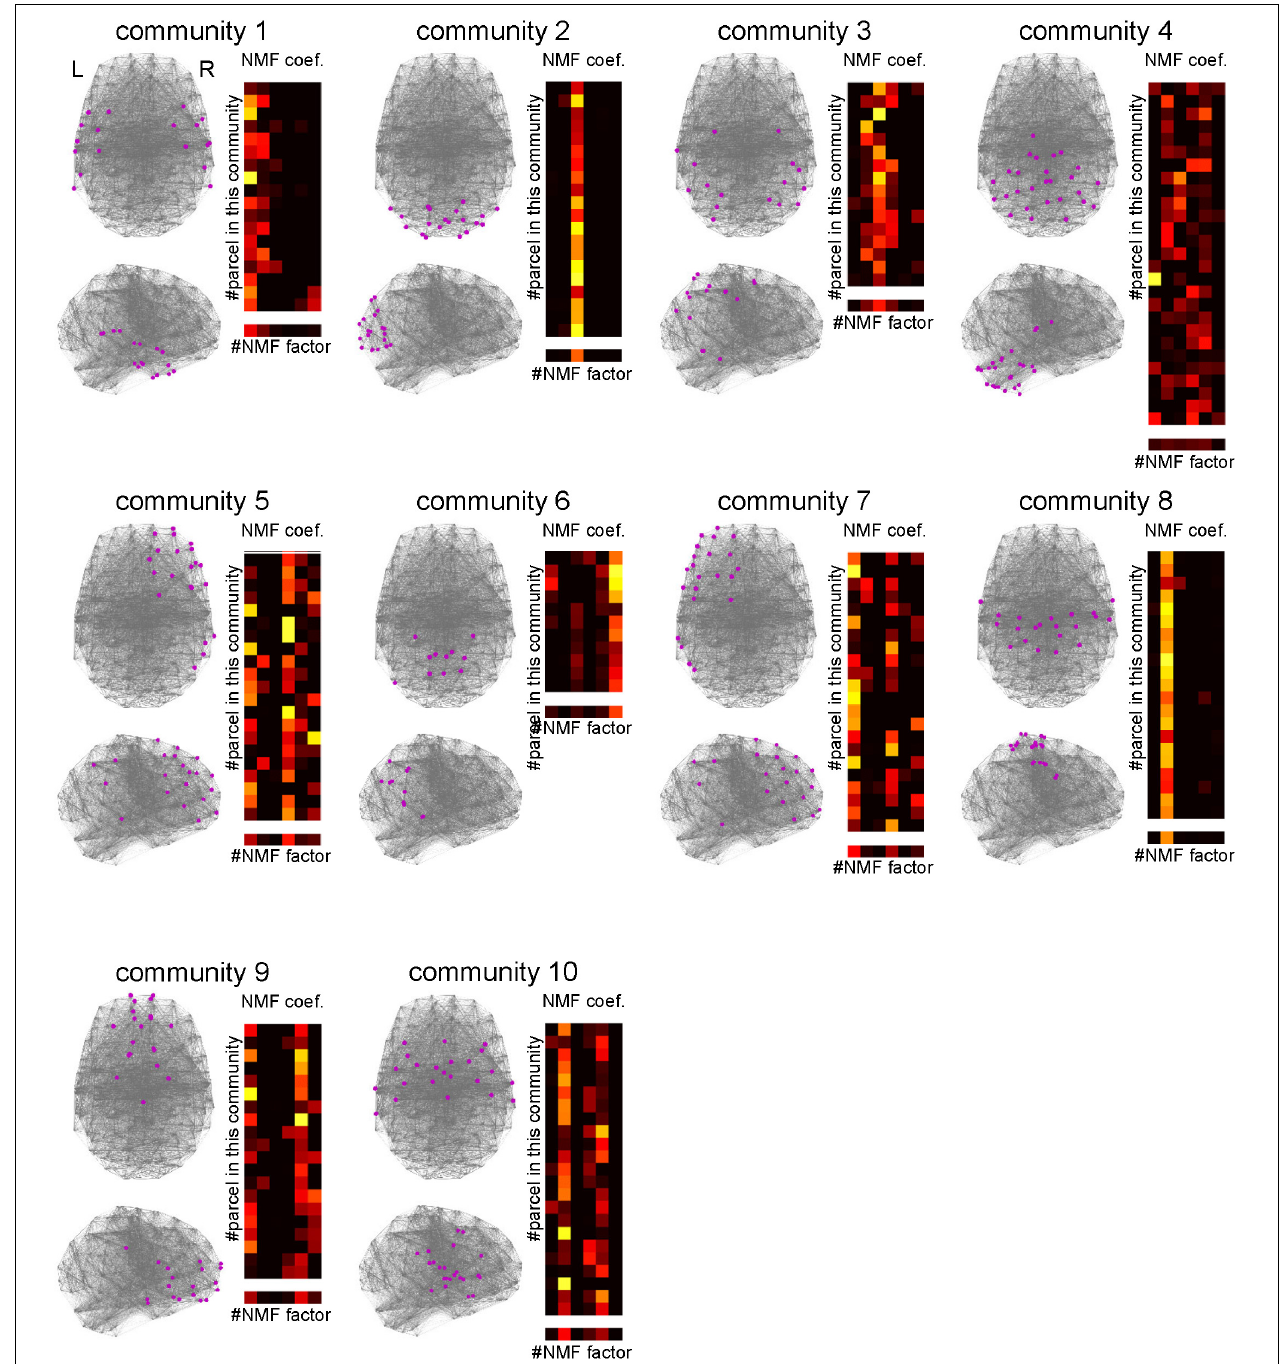
FIGURE 9 | Characterizing communities in the whole-brain network with the cognitive factors. Ten network communities were identified using spectral clustering. The parcels belonging to each community are shown by magenta dots. For each community, the subpart of the non-negative matrix factorization coefficient matrix corresponding to the parcels in the community is shown on the right. The lowest row shows the row mean of the